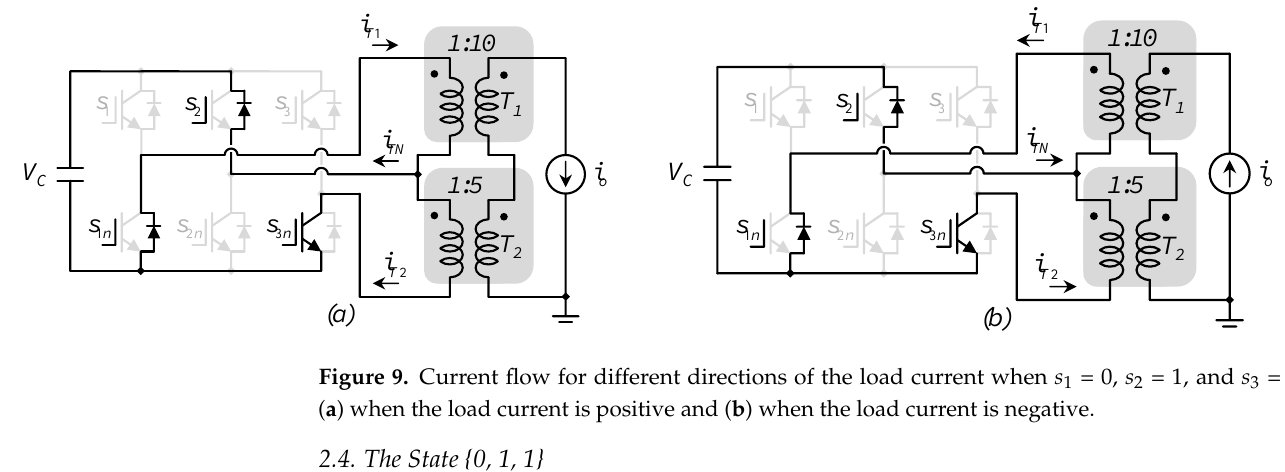
Figure 9. Current flow for different directions of the load current when s 1 = 0, s 2 = 1, and s 3 = 0. (a) when the load current is positive and (b) when the load current is negative. 2.4. The State {0, 1, 1}